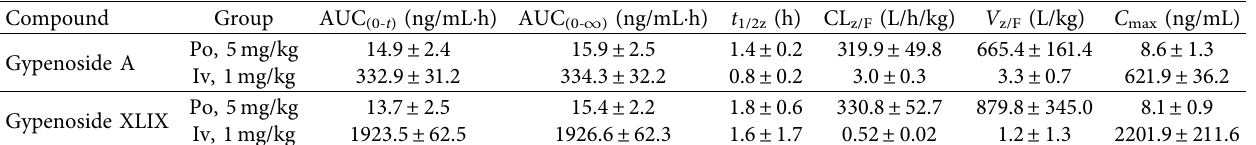
Table 3: Main pharmacokinetic parameters after intravenous (iv) and oral (po) administration of gypenoside A and gypenoside XLIX in rats. Compound